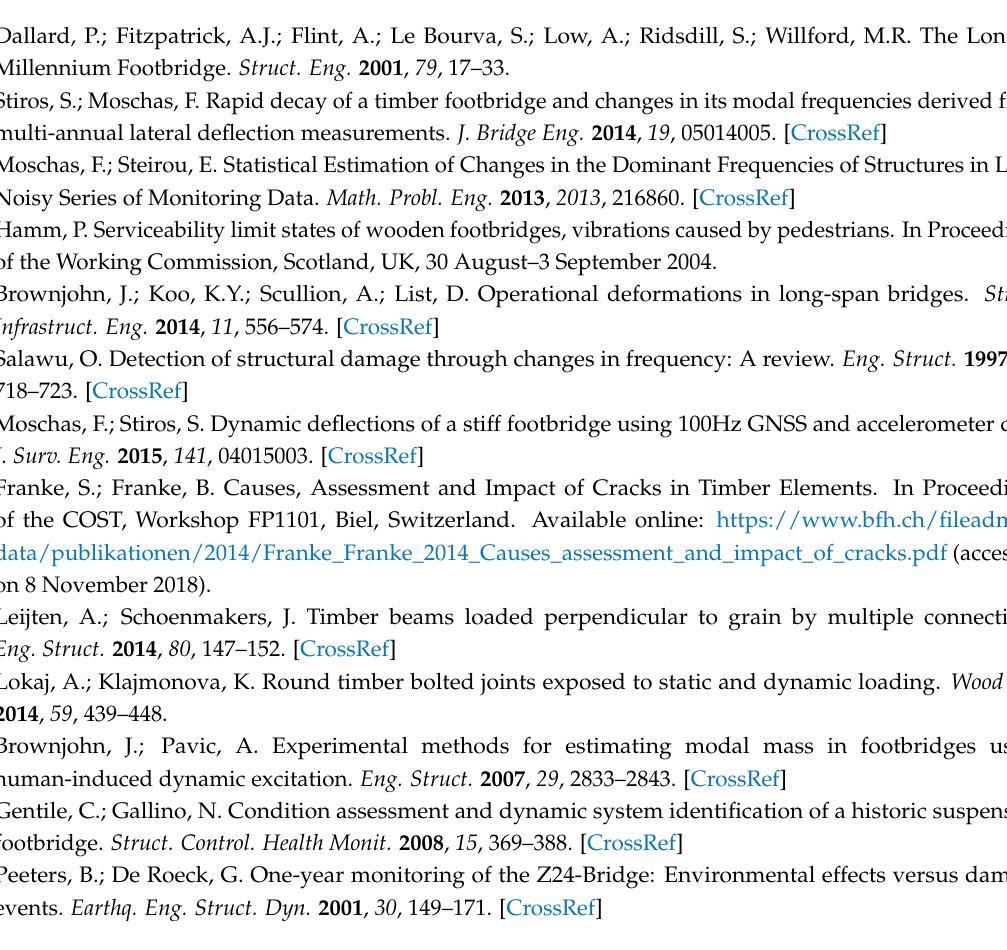
Figure A2. Superimposed accelerometer-derived spectra of selected free attenuating vertical oscillations during the 2007, 2009 and 2010 surveys, normalized to their maximum value ( left ) and zoomed around the dominant peak (natural frequency, right ). Mark consistency of curves, permitting to define vertical modal frequencies of the bridge with resolution of a fraction of a Hz. The shift between 2007–2009 and the absence of shift between 2009–2010 is consistent with damage derived from lateral deflections, and indicates no significant structural damage along the vertical axis (after [24]).